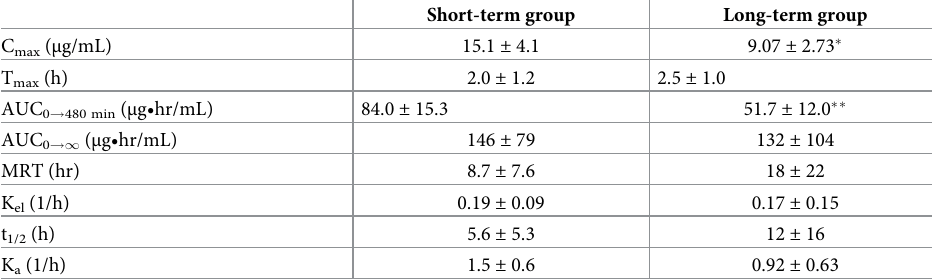
Table 3. Pharmacokinetic parameters of concurrent administration of CBZ and